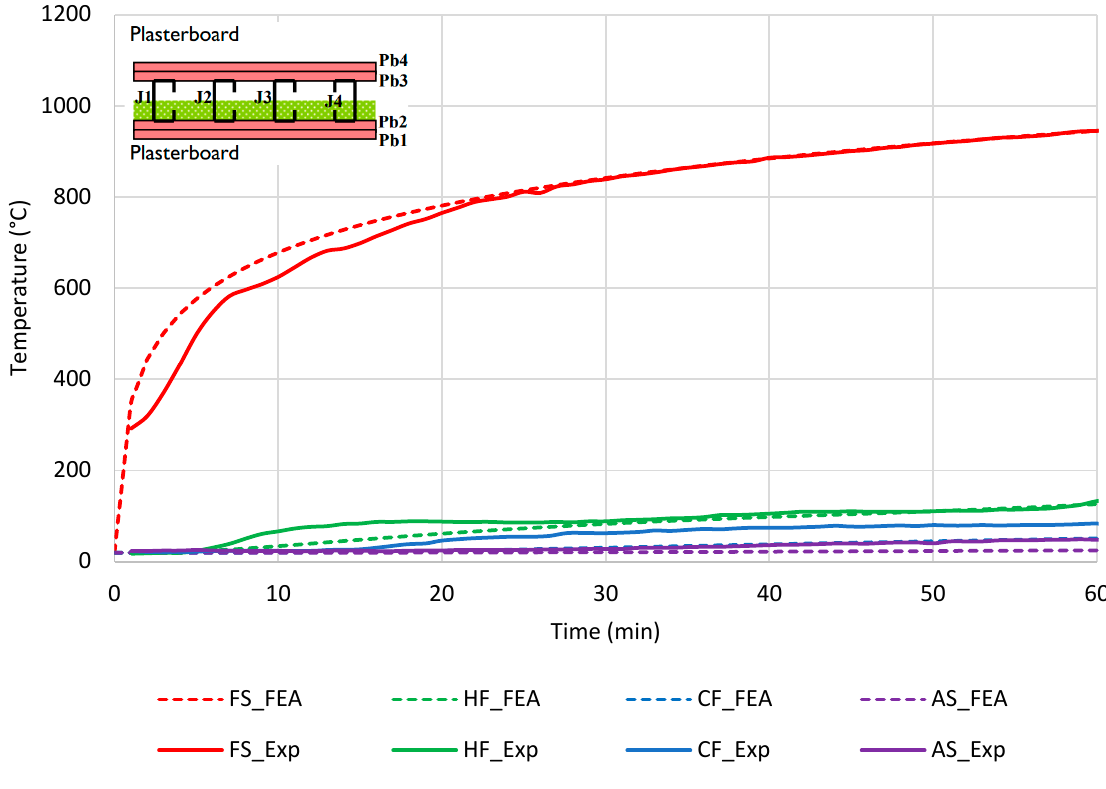
Figure 6. FEA versus experimental temperatures of floor panel specimen—Tests 2 [1].